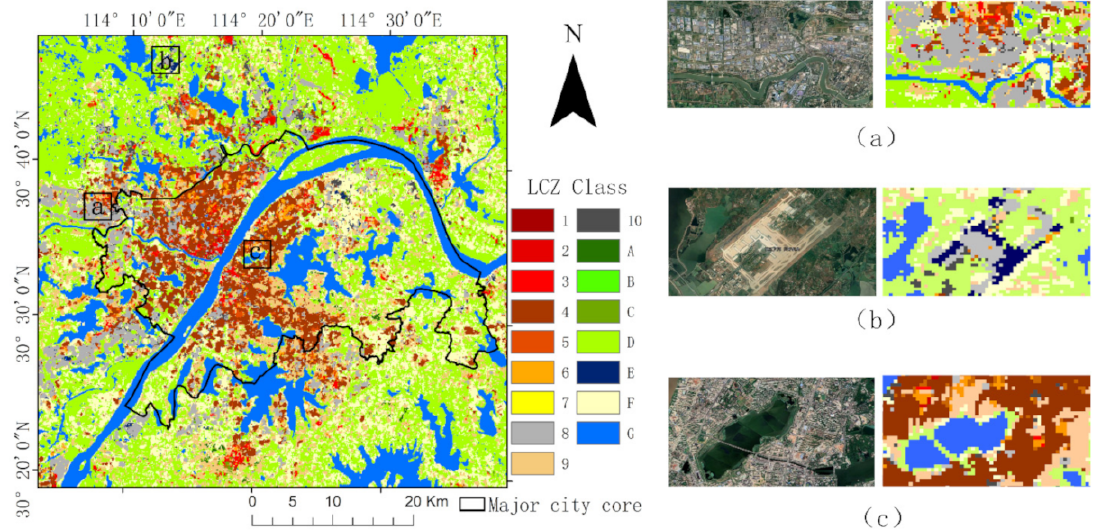
Figure 4. Classification map of LCZs in the main urban area and surrounding areas from Sentinel-2 image acquired on 9 April 2020. ( a ) Area containing industrial park; ( b ) area containing Tianhe International Airport; ( c ) area containing park, vegetation, and